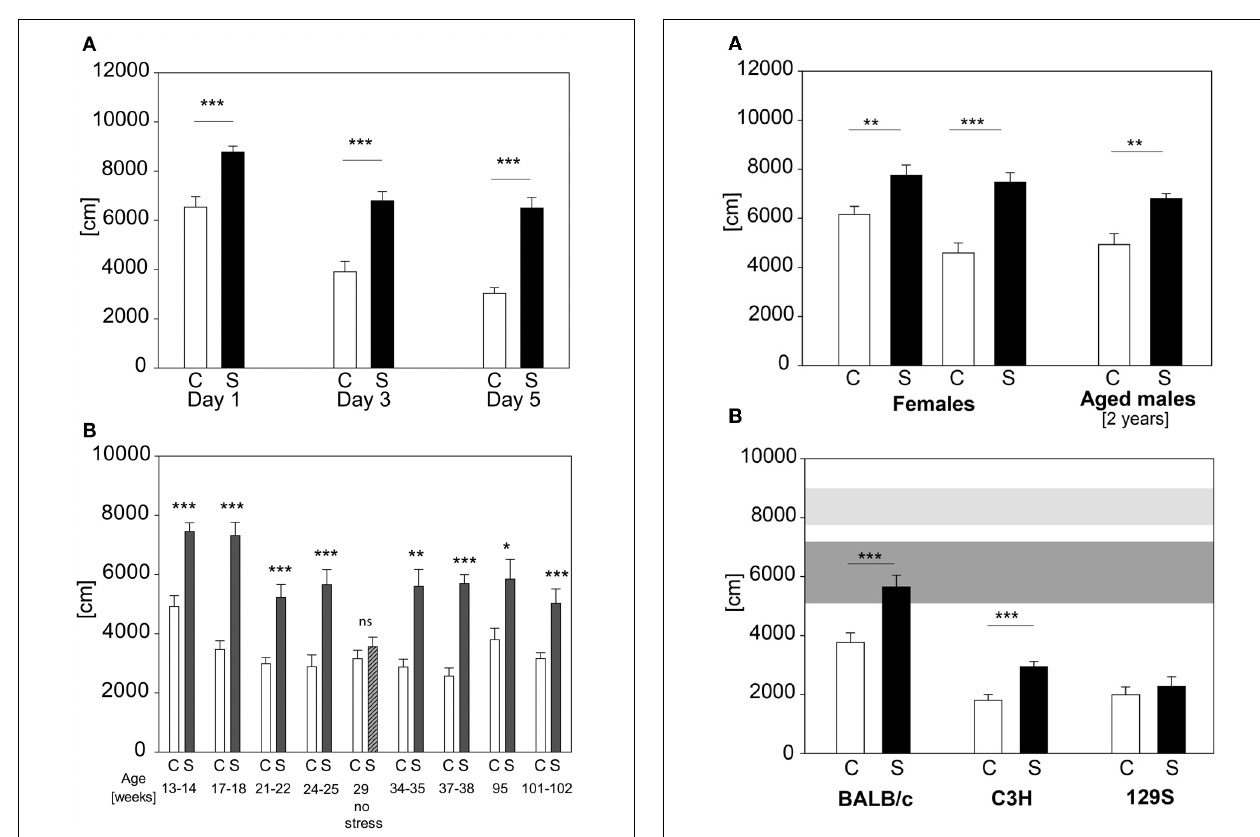
FIGURE 8 | Repeated exposure to acute stress. When re-testing the same animals every second day the increased activity in distance traveled (A) in the first 5min of the OF persists and does not fade-out nor vanish. In graph (B) the distance traveled in the first 5min of the OF after repeated exposure to the acute restraint stress protocol throughout life time is depicted. At the age of 29 weeks the stressed group was tested for development of a conditioned response to the OF, by not stressing them, but placing them into the OF directly from the home cage, as done with controls. The lack of an increase of activity demonstrates that the animals of the stress group did not respond to the environment they were placed into but to the actual stressor, namely restraint. Control groups, C, in white and stress groups, S, in black bars. Error-bars are shown as s.e.m.; Significances: ∗ p ≤ 0 . 05; ∗∗ p ≤ 0 . 01; ∗∗∗ p ≤ 0 . 001 vs. C; n = 12 per group; gradual decline in animal numbers in graph (B) to n (C) = 11 and n (S) = 7 at the end of repeated stress exposure.